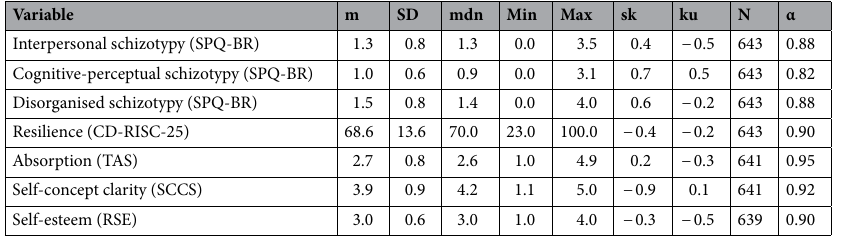
Table 1. Descriptive statistics. m mean, mdn median, sk skewness, ku